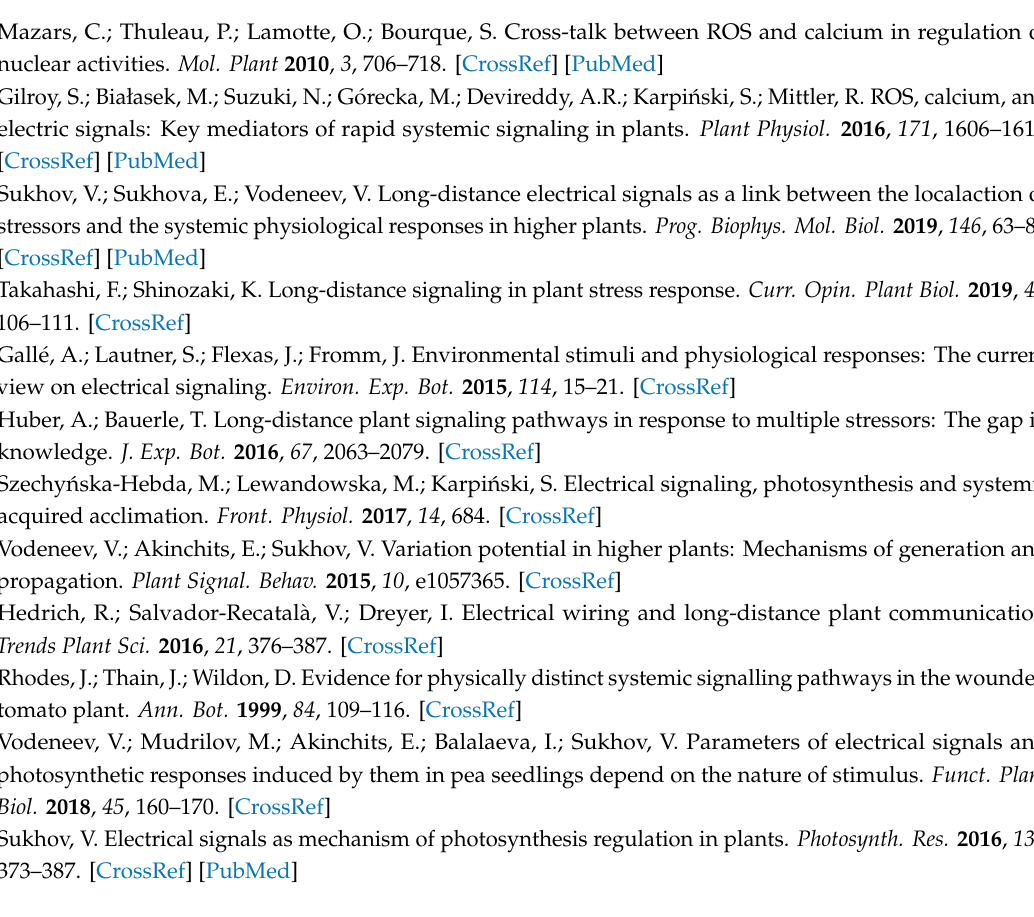
Table S1. Average maximum wavelet coefficients (Wmax) obtained at continuous wavelet transform (CWT) procedure with di ff erent scales for five records of multielectrode electrical potential registration in pea seedlings, Table S2. Average maximum wavelet coefficients (Wmax) obtained at continuous wavelet transform (CWT) procedure with di ff erent scales for five records of multielectrode electrical potential registration in wheat seedlings, Table S3. Amplitude (mV) of the heating-induced variation potential (VP) in pea seedlings, calculated using manual (MP) or automatic processing (AP) (scale 5), Table S4. Amplitude (mV) of the heating-induced variation potential (VP) in wheat seedlings, calculated using manual (MP) or automatic processing (AP) (scale 10), Table S5. The start time (s) of the heating-induced variation potential (VP) in pea seedlings, calculated using manual (MP) or automatic processing (AP) (scale 5), Table S6. The start time (s) of the heating-induced variation potential (VP) in wheat seedling, calculated using manual (MP) or automatic processing (AP) (scale 10), Table S7. Amplitudes of VP-induced changes in CO 2 assimilation rate (A, µ mol m − 2 · s − 1 ), transpiration level (E, mmol m − 2 · s − 1 ), quantum yields of photosystems I and II (YI and YII) and non-photochemical fluorescence quenching (NPQ) in pea seedling leaves, calculated using manual (MP) or automatic processing (AP) (scale